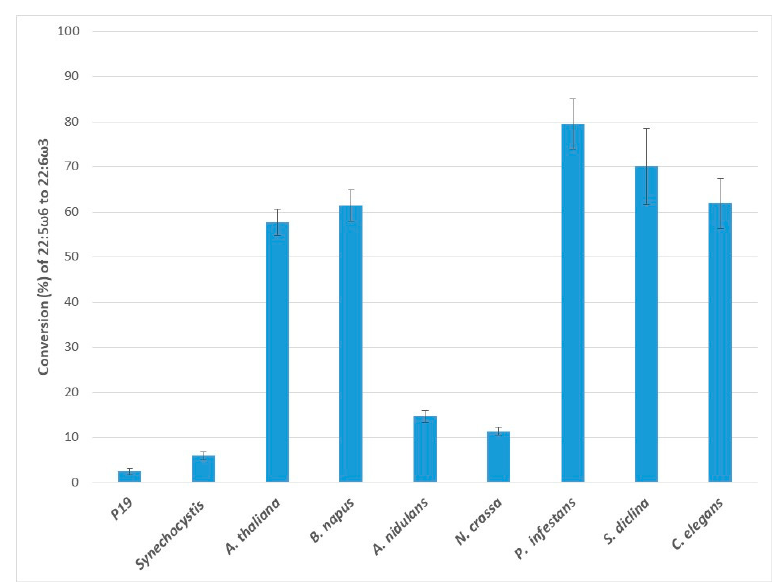
Figure 6. Enzymatic activities of transiently expressed ω 3Ds from various sources in N. benthamiana leaves on 22:5 ω 6 substrate. ω 3D activities were determined by measuring the conversion rate of provided 22:5 ω 6 substrate to 22:6 ω 3 in leaves expressing p19 silencing suppressor only as a control or the appropriate ω 3D with p19. The error bars denote the standard deviations of the means from triplicate assays.